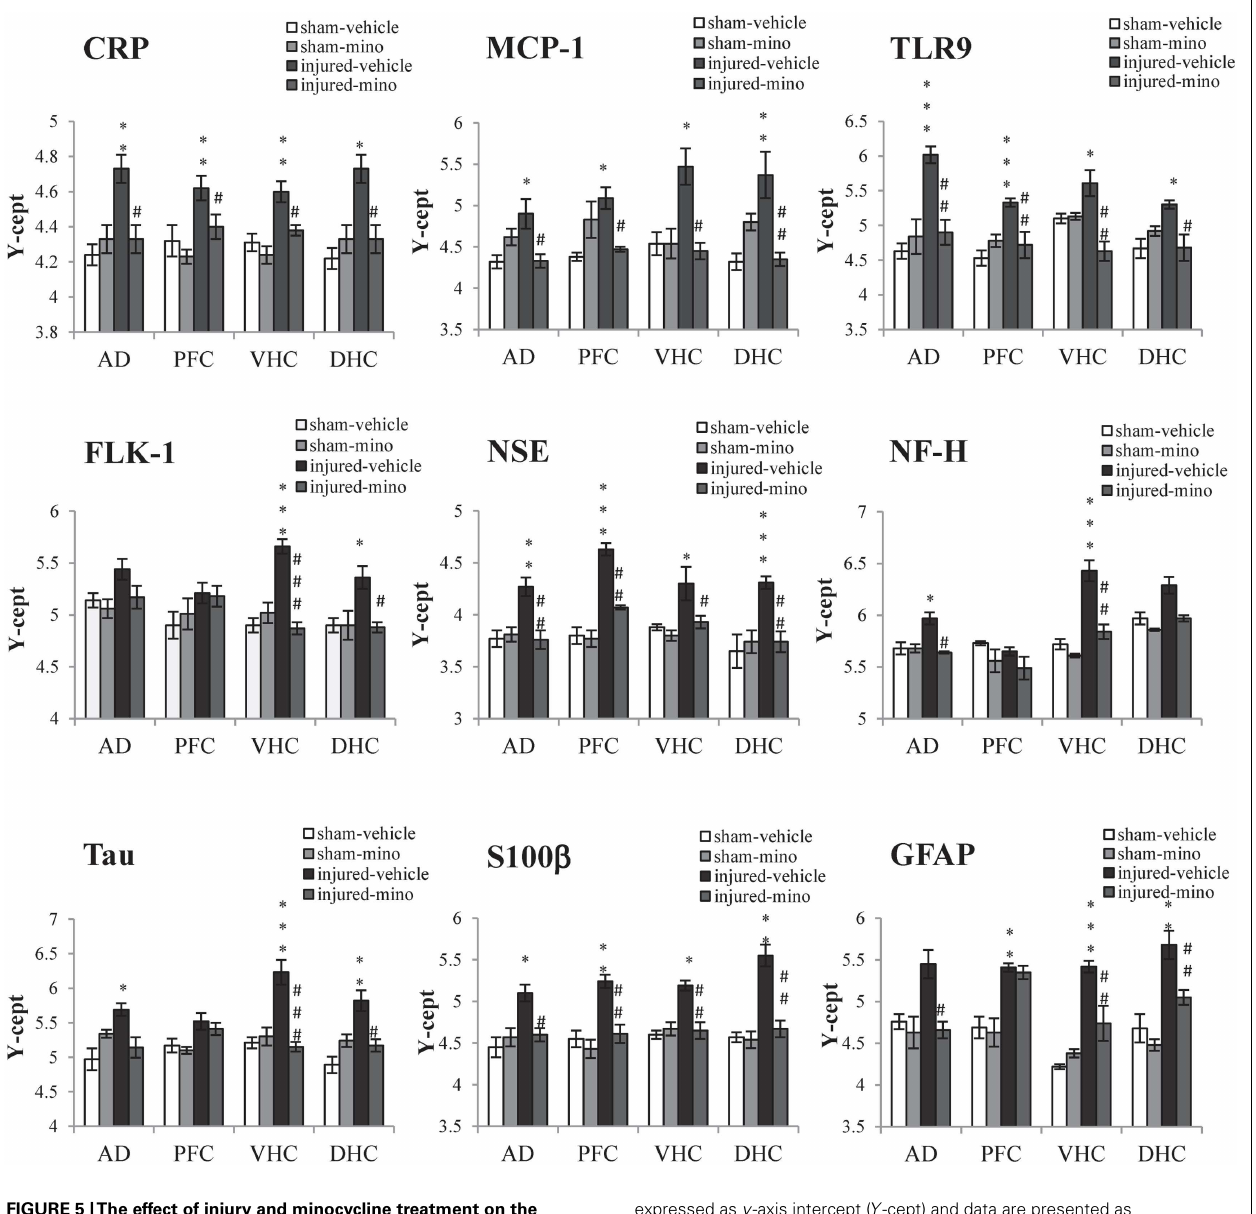
expressed as y -axis intercept ( Y -cept) and data are presented as mean ± SEM. * p < 0.05, ** p < 0.01, and *** p < 0.001 for injured-vehicle vs. sham-vehicle rats. # p < 0.05 and ## p < 0.01 for injured-vehicle vs. injured-mino